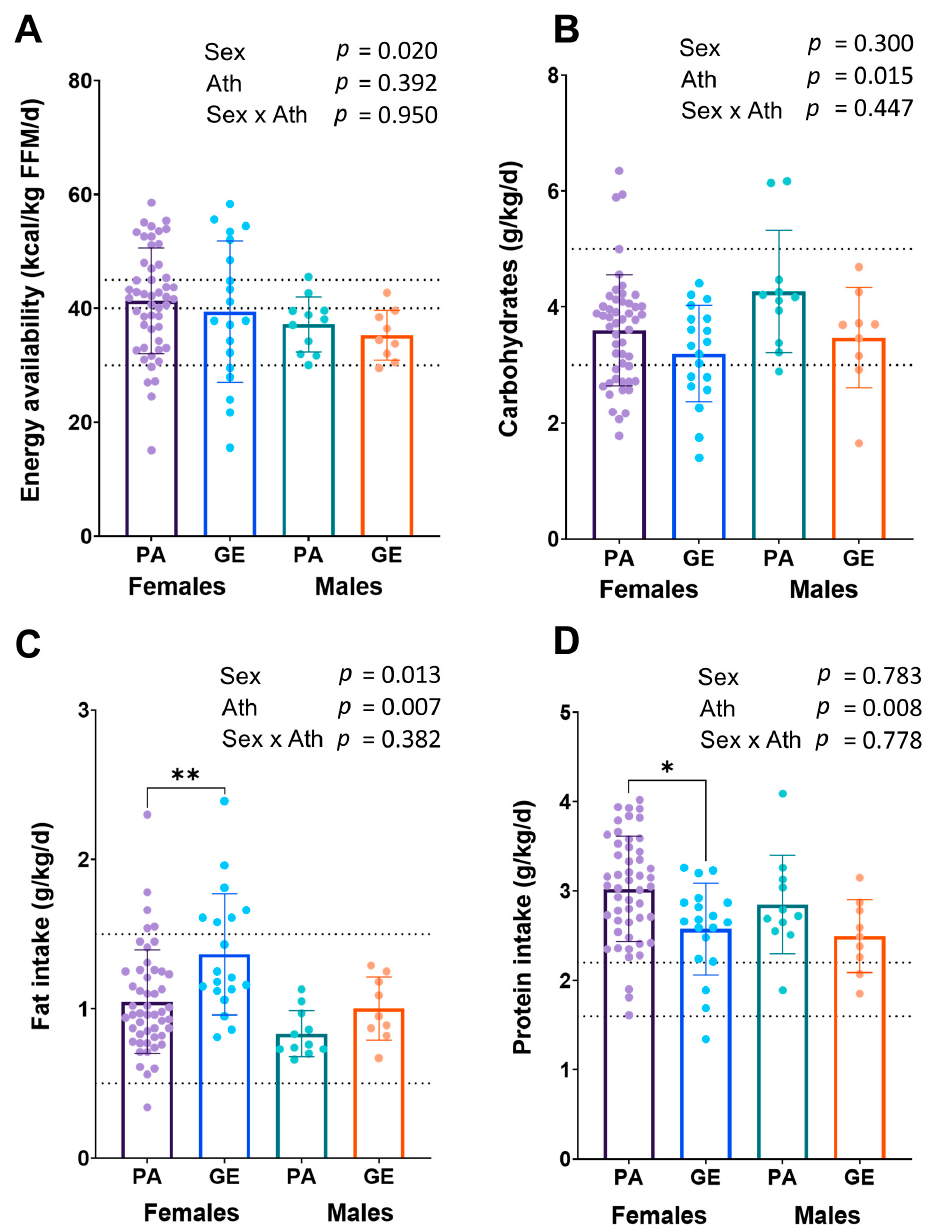
Figure 1. Energy availability ( A ) and macronutrient intakes ( B – D ) in physique athletes (PA) and gym enthusiasts (GE). 2 × 2 ANOVA (main and interaction effects) p -values are shown as text above the bars and possible post hoc (Tukey’s test) differences in mean values between individual groups. * = p < 0.05 and ** = p < 0.01. Ath = athlete status (PA or GE). Dashed lines for EA ( A ) show low (<30 kcal/kg FFM) and optimal values (> 40/45 kcal/kg FFM) and for macronutrient intakes ( B – D ) recommended values for bodybuilders in the off-season